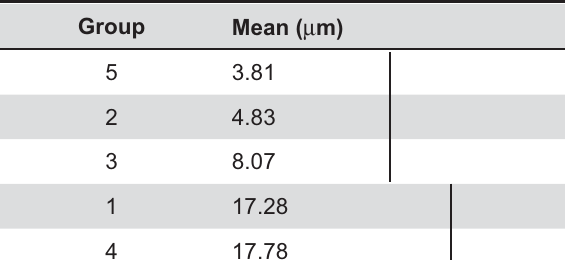
Table 3- Comparisons of groups after the fatigue test